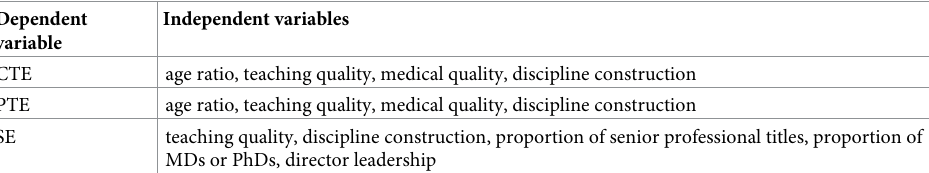
Table 6. Variables included in the